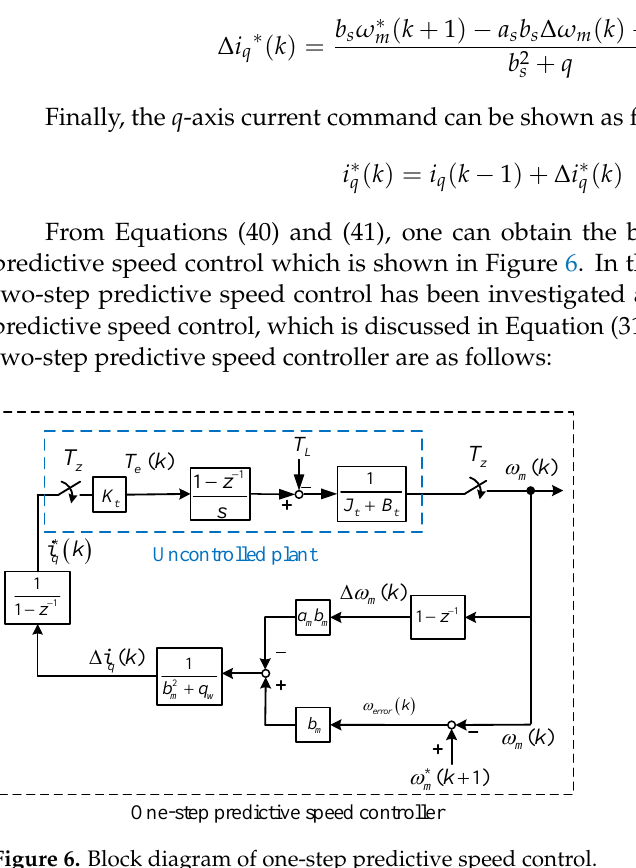
Figure 6. Block diagram of one-step predictive speed control.